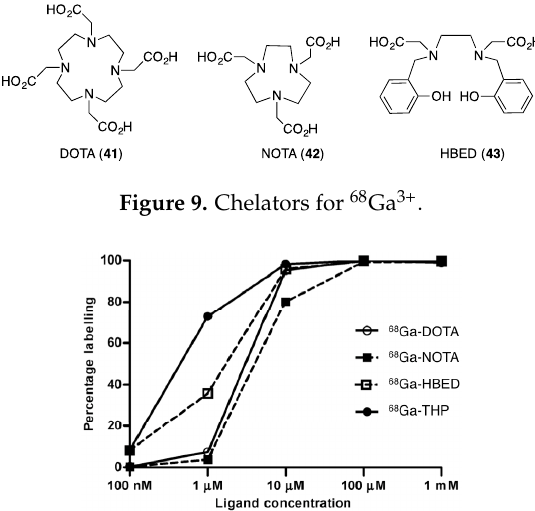
Figure 10. Radiolabelling yield versus ligand concentration for 68 Ga-DOTA (pH 4.4, 30 min, 100 °C), 68 Ga-NOTA (pH 3.6, 10 min, room temperature), 68 Ga-HBED (pH 4.6, 10 min, room temperature) and 68 Ga-THP, (pH 6.5, 5 min, room temperature). All experiments were conducted with the same batch of 68 Ga eluate. All radiolabelling buffers were 0.2 M acetic acid/sodium acetate. Reprinted with permission from Berry, D.J.; et al. Efficient bifunctional gallium-68 chelators for positron emission tomography: tris(hydroxypyridinone) ligands. Chem. Commun. 2011 , 47 , 7068–7070. Copyright Royal Society of